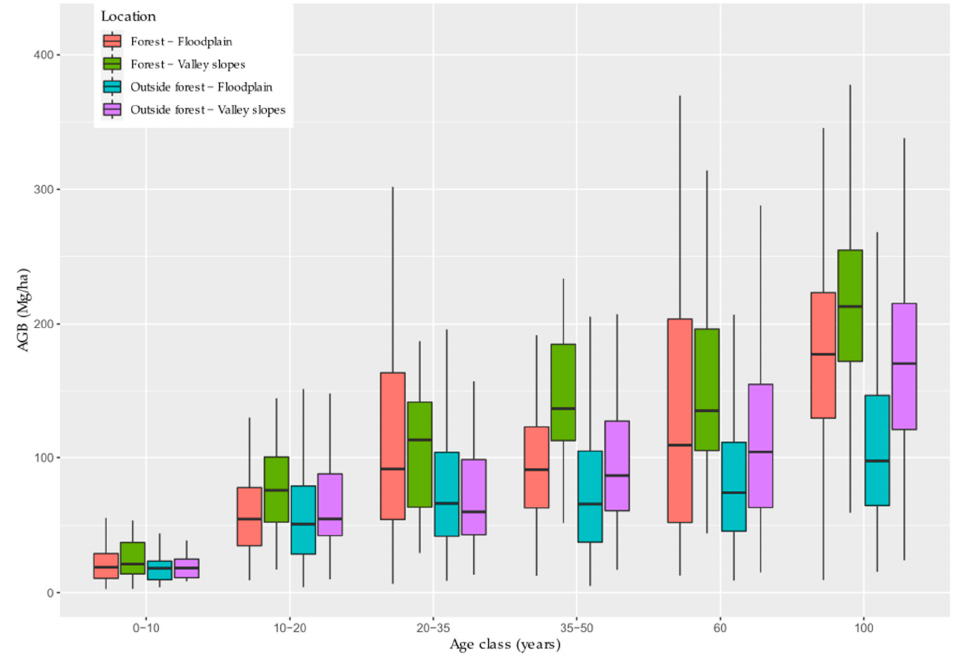
Figure 7. Aboveground biomass of VU depending on their age and location inside (Forest in VU > 50%) or outside forest, in the floodplain (Relative vertical distance < 1) or on valley slopes. Age classes “60” and “100” are indicative values, see Section 2.7.